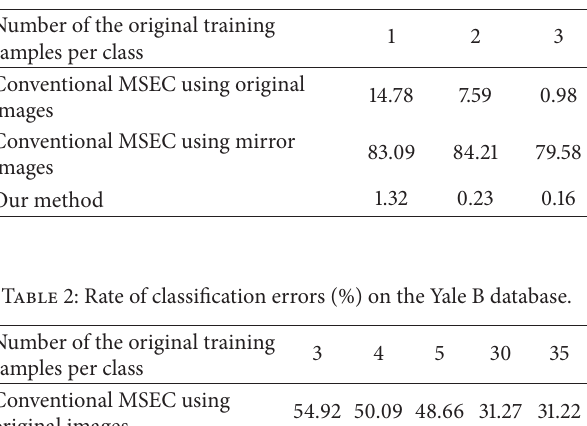
Table 1: Rate of classification errors (%) on the PIE database.